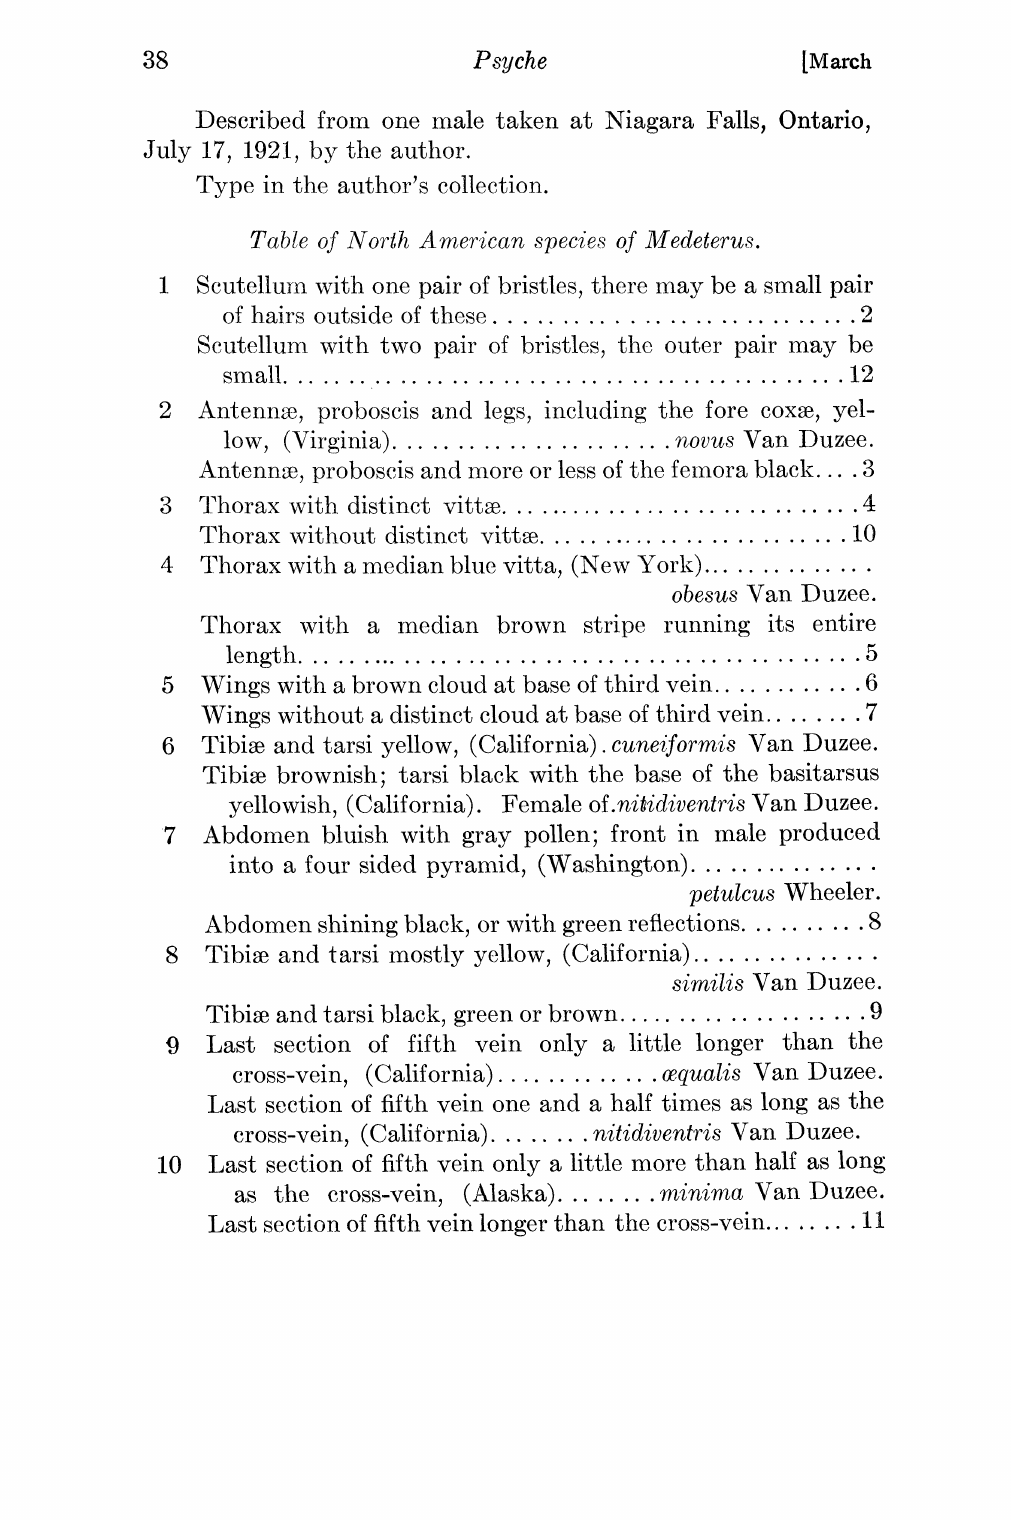
Table of North American species of